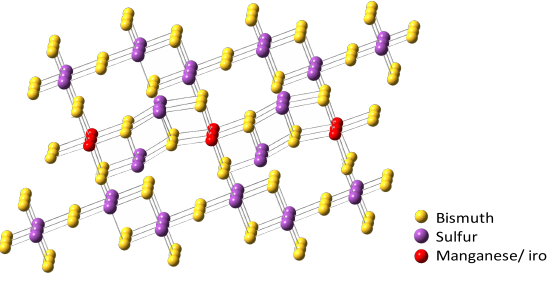
Figure 8: Crystal structure of MnBi 4 S 7 and FeBi 4 S 7 .